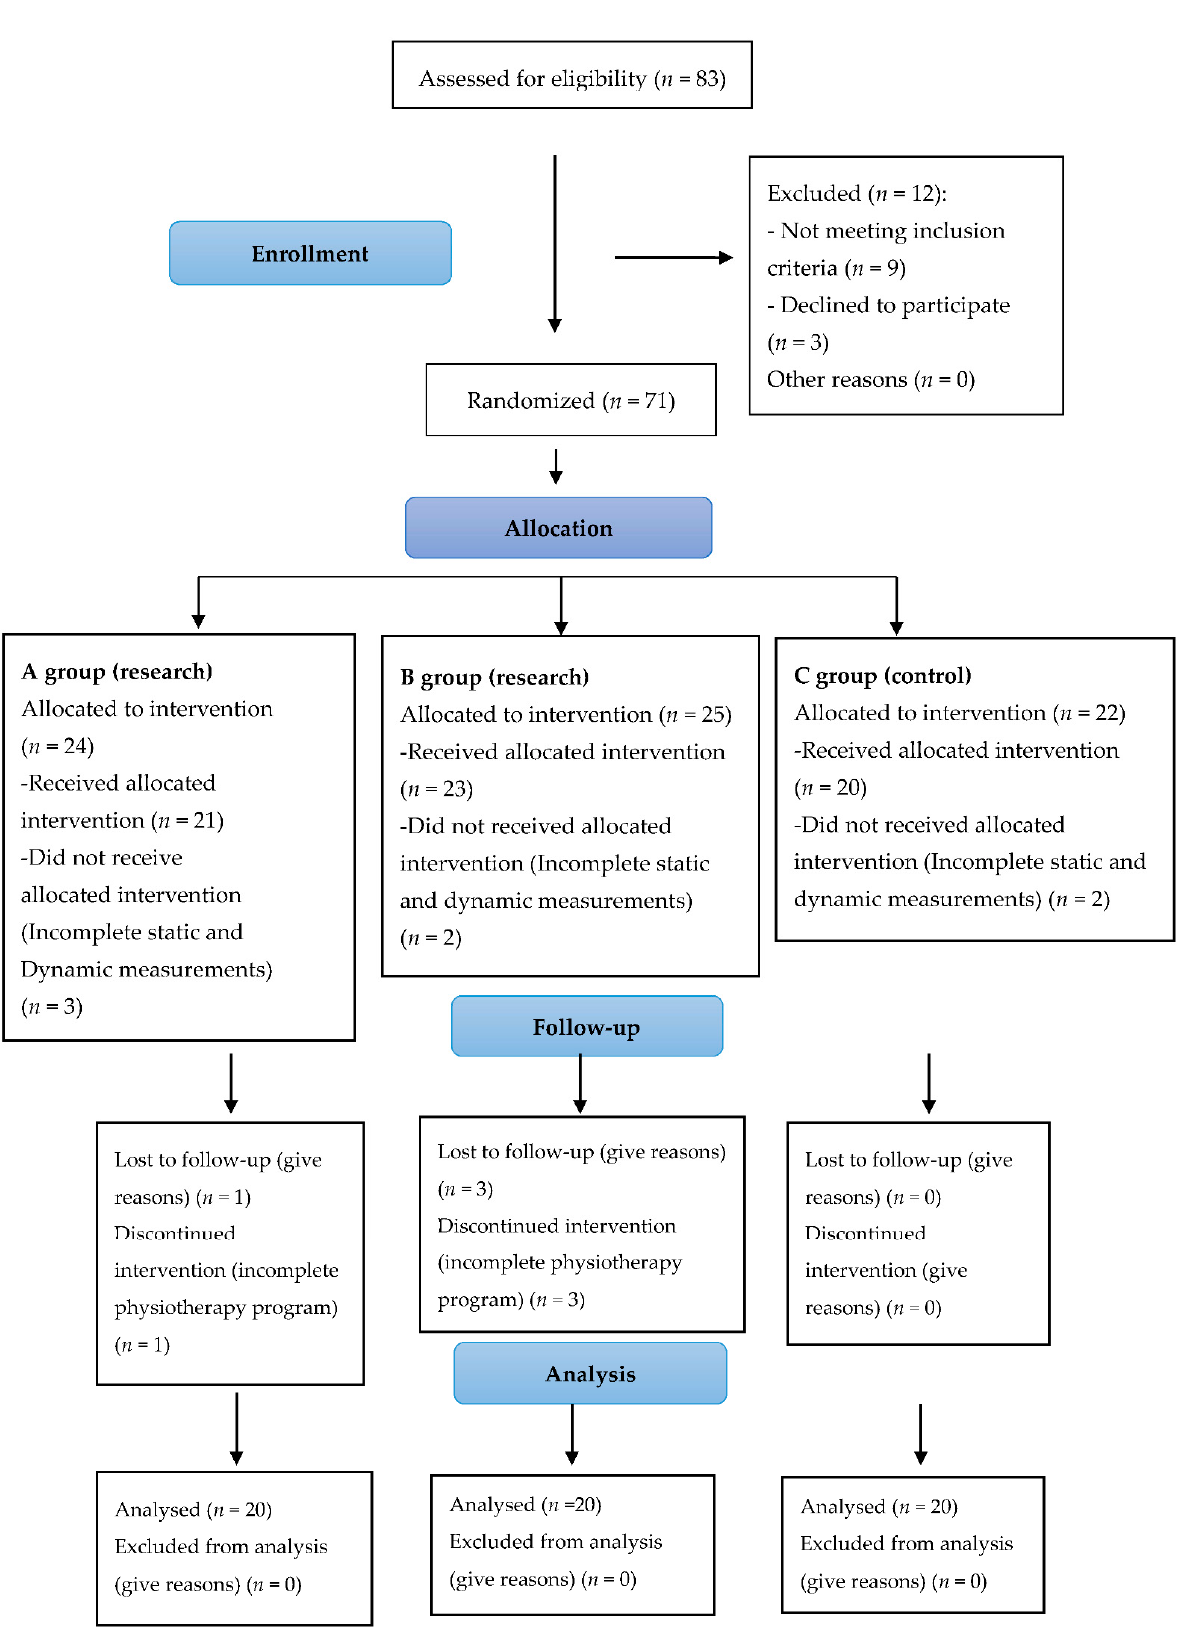
Figure 1. Consort Figure 1. Consort diagram.